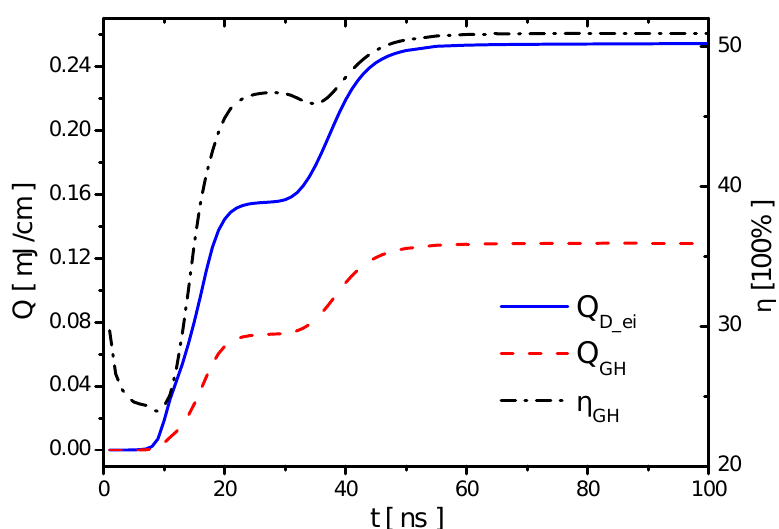
Figure 19. The discharge energy Q D _ ei , the fast gas heating Q GH and the gas-heating efficiency η GH in Case 1.